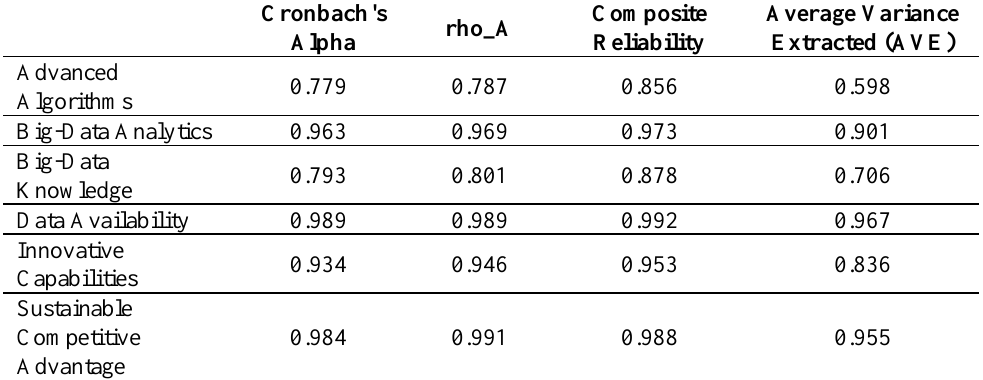
Table.3. Construct Reliability and Convergent Validity